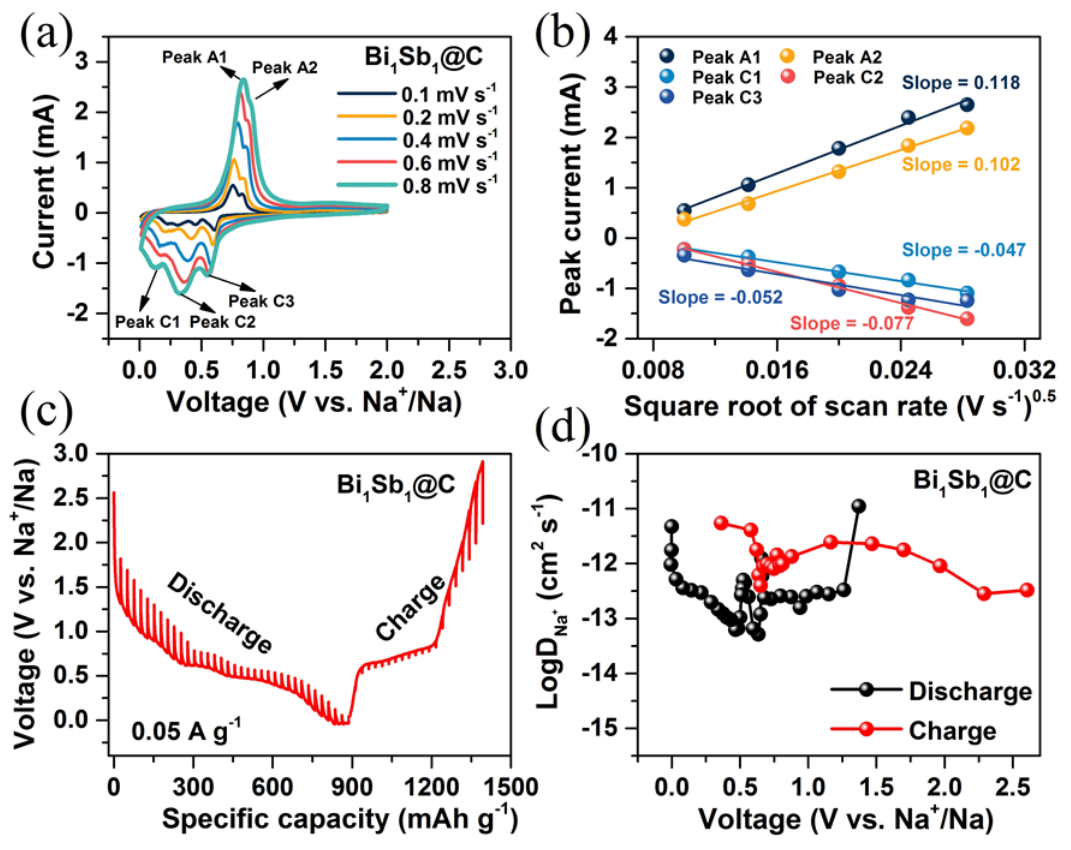
Figure 5. ( a ) CV results of the Bi 1 Sb 1 @C electrode at sweep rates from 0.1 to 0.8 mV s − 1 . ( b ) Linear relationship between i p and v 0.5 . ( c ) GITT curves of the Bi 1 Sb 1 @C sample at 0.05 A g −1 . ( d ) Corresponding diffusion rate for Na + calculated from the GITT results during the first cycle.